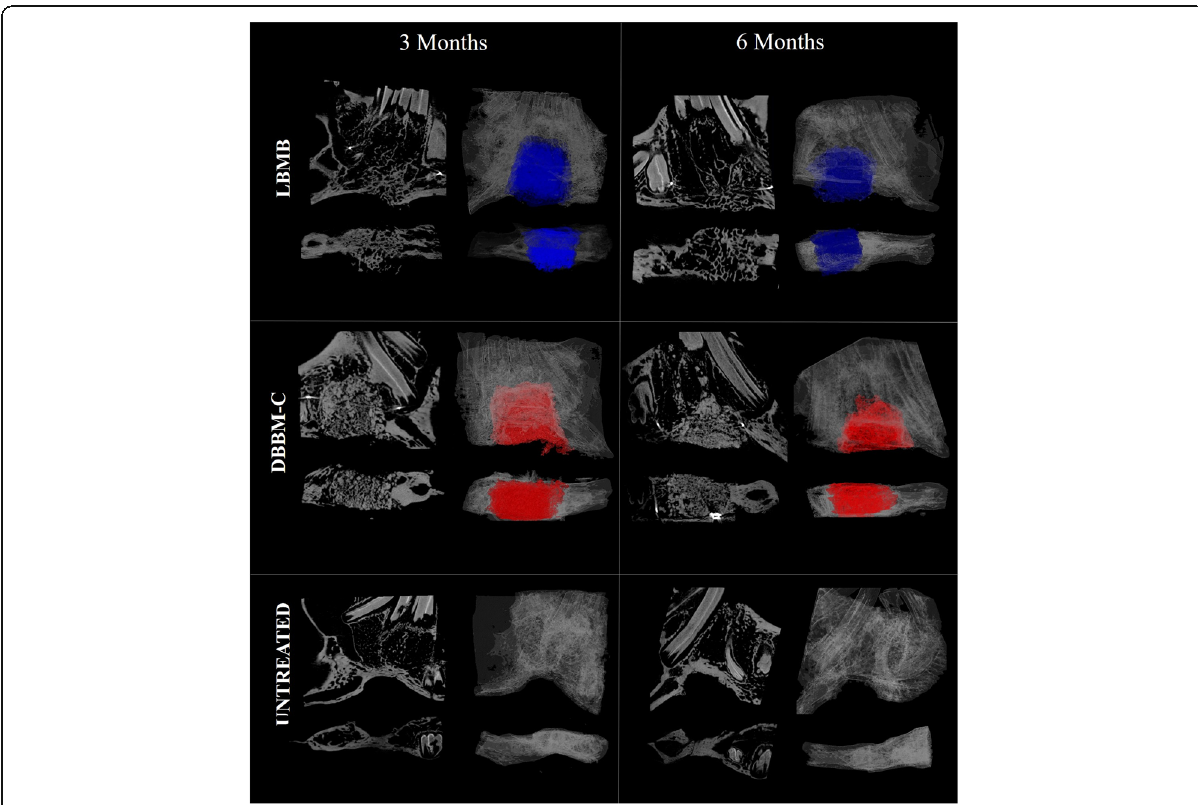
Fig. 4 Micro-CT imaging of the bony defects filled with deproteinized bovine bone mineral with collagen (DBBM-C), lyophilized bovine medullary bone (LBMB)or left untreated after 3 or 6 months post-operative